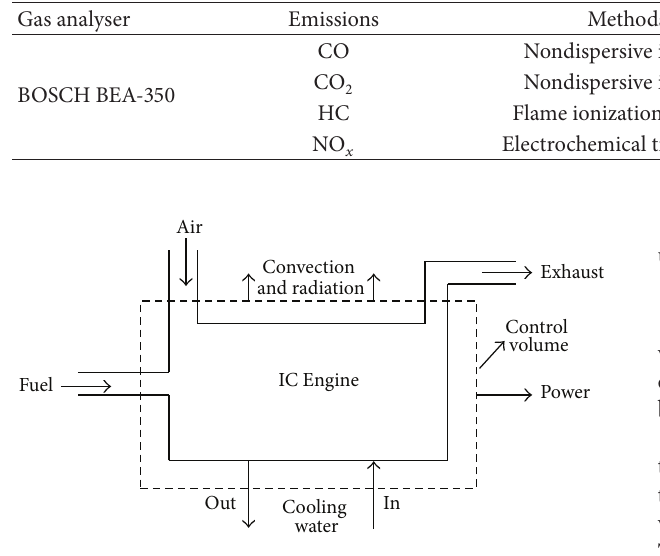
Table 3: Exhaust gas analyser specification.